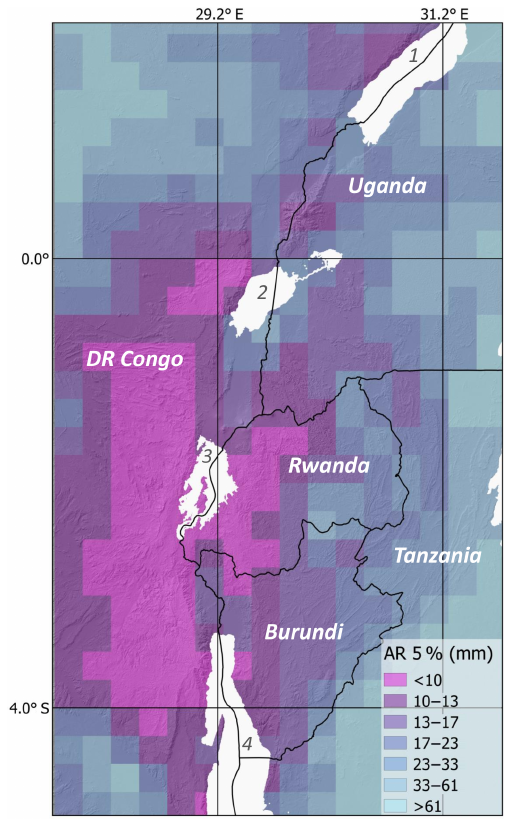
Figure 5. Antecedent rainfall (AR) threshold map (0.25 ◦ res- olution) at 5% exceedance probability (see Eq. 5). Depending on the local landslide susceptibility (from Broeckx et al., 2018, Fig. 1) threshold values range from AR = 9.5mm in the highest- susceptibility areas ( S = 0 . 97) to AR = 23.1mm in the least suscep- tible pixels ( S = 0 . 38), having recorded landslides during the 2001– 2018 period. Numbers in the lakes are as follows. 1: Lake Albert; 2: Lake Edward; 3: Lake Kivu; 4: Lake Tanganyika. Background hillshade SRTM